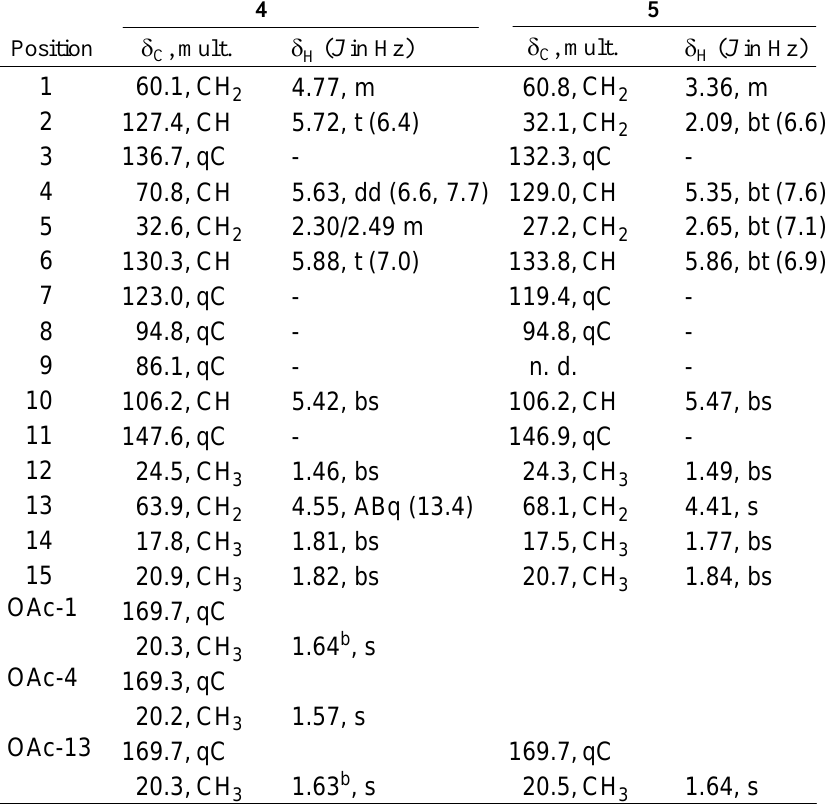
D ) for dihydro- 6 6